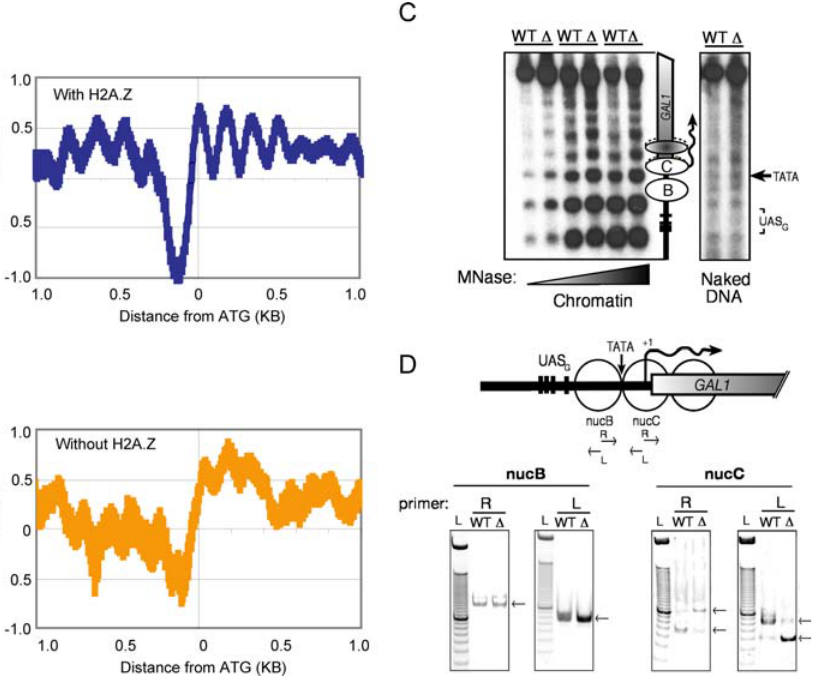
Figure 4. H2A.Z Regulates Nucleosome Positioning (A) Nucleosome positioning map of genes associated with a Z locus. The data from Yuan et al. [37] were used to compute the nucleosome occupancy curve for all genes containing a Z locus aligned on their ATG. Peaks represent nucleosomes, and valleys represent linker regions. An NFR is detected approximately 200 bp upstream of ATGs as described by Yuan et al. [37]. The vertical thickness of the curves contains 1-SD error bars for the mean log 2 ratio. (B) Same as (A) but for genes containing no Z locus. (C) Indirect end-labeling of MNase-digested chromatin from WT and htz1 D cells grown in the presence of glucose. (D) High-resolution LM-PCR analysis of MNase digested nucB–C mononucleosomes. Upper part: structure of the GAL1 promoter and PCR probes used; left: nucB analysis probing the right (R), and left (L) boundaries in WT and htz1 D ( D ) cells; right: same as left part of the figure, but the analysis is with nucC. DOI: